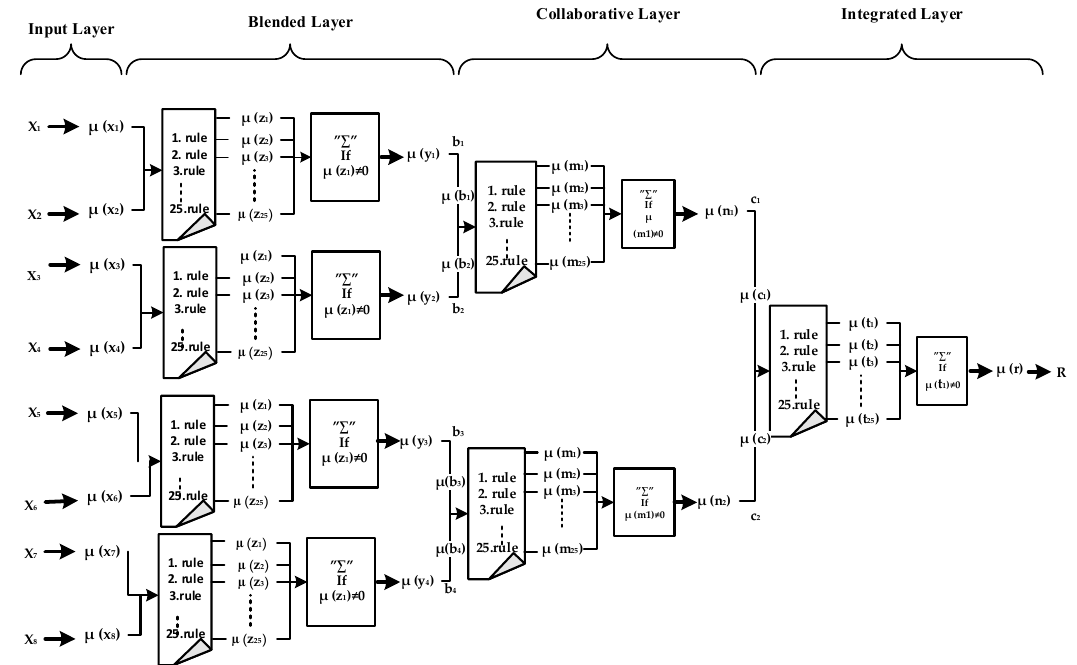
Figure 3. Processing diagram of the proposed integrated risk index model based on hierarchical fuzzy logic.